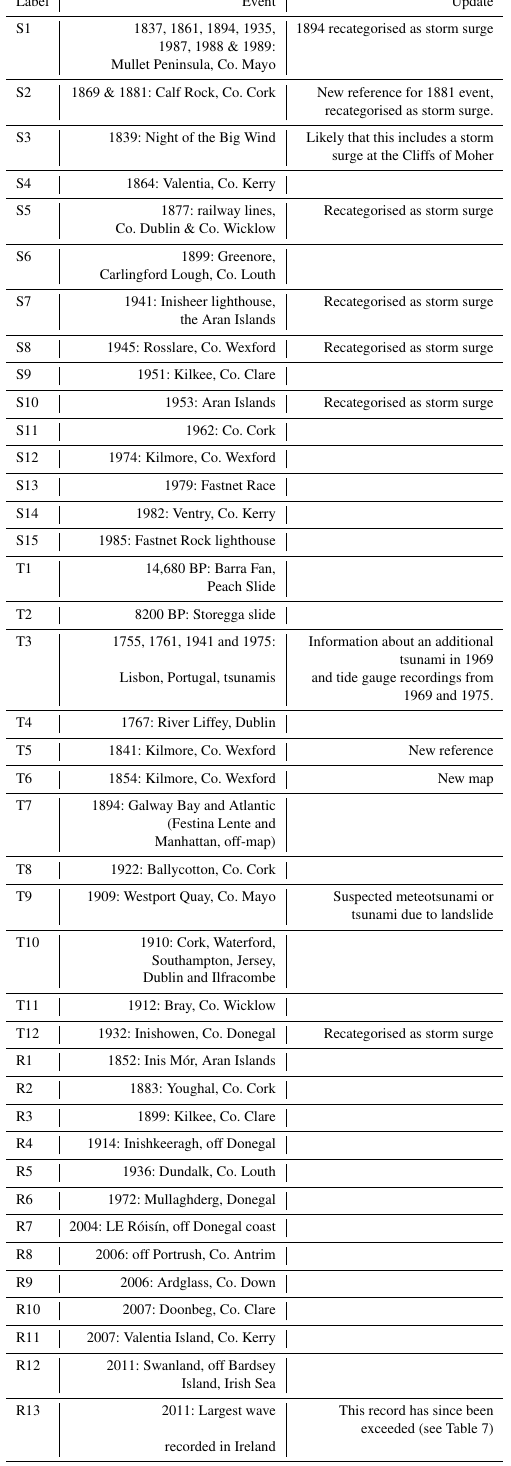
Table 2. List of events from O’Brien et al. (2013) with any new information or